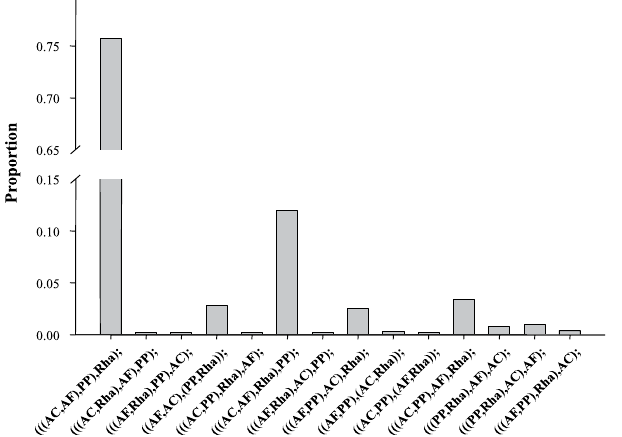
Figure 4. A histogram depicting the proportions of 14 tree topologies with average bootstrap values above 70%, inferred from 2555 orthologous genes in the MP-EST analysis. Rha, Rhagophthalmus sp.; AC, Asymmetricata circumdata ; AF, Aquatica ficta ; PP, Pyrocoelia pectoralis